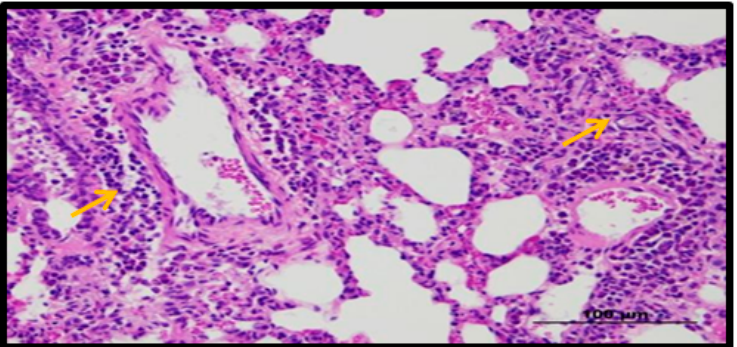
Figure 9. Histology of the polymorphonuclear and mononuclear cell infiltrate the various treated rat groups. Histology in the healthy rat lung was within normal limits (less inflammatory cells), whereas the TRF-treated rat showed a notable decrease in inflammatory cells compared to those of the other groups. Yellow arrows indicate polymorphonuclear and mononuclear cell infiltrate; blue arrows indicate giant cell infiltrate.